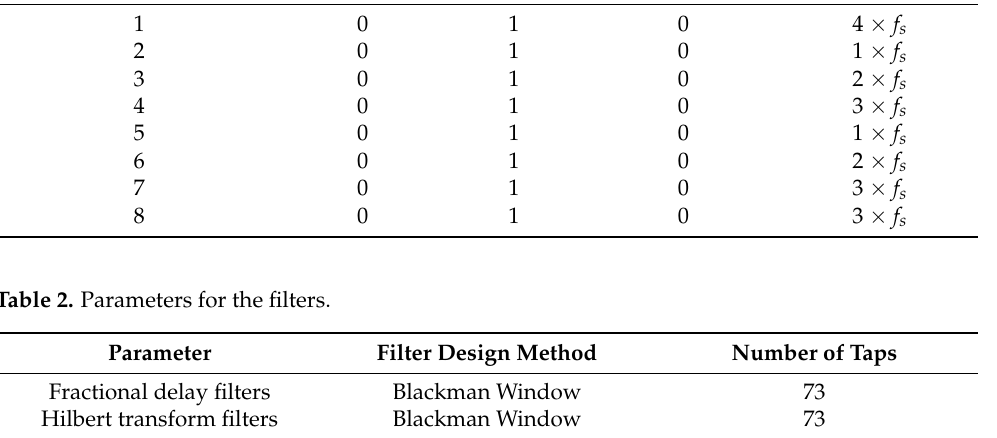
Table 2. Parameters for the filters.